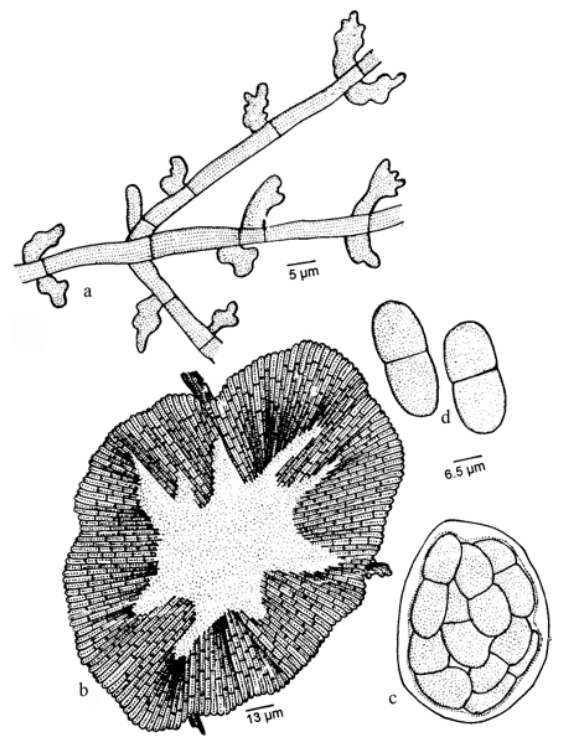
Figure 154. Asterina melicopecola a - Appressorium; b - Thyriothecium; c - Ascus; d -